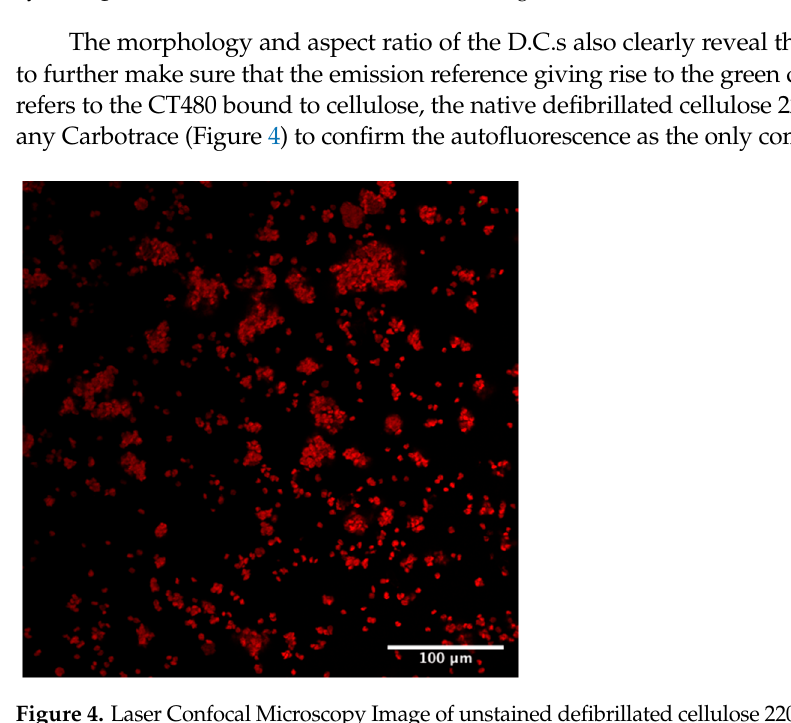
Figure 3. Laser Confocal Microscopy images of CT480 mixed with pure cellulose ( left ) and pure xylan ( right ) with the exact same instrument settings.